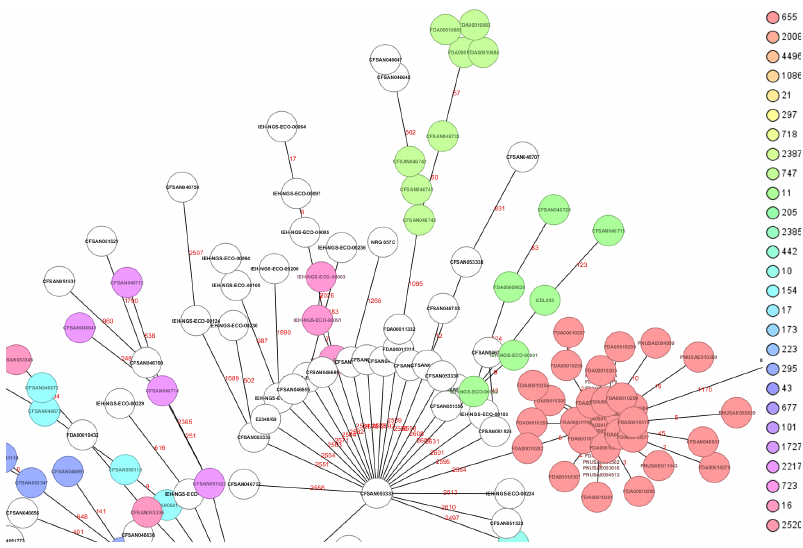
Fig 2. View of a segment from the minimum spanning tree (MST) showing the relationships among all different STECs (complete MST in S1 Fig). The numbers above the connected lines (not to scale) represent allele differences between strains belonging to the same ST. The isolates are colored based on different STs as